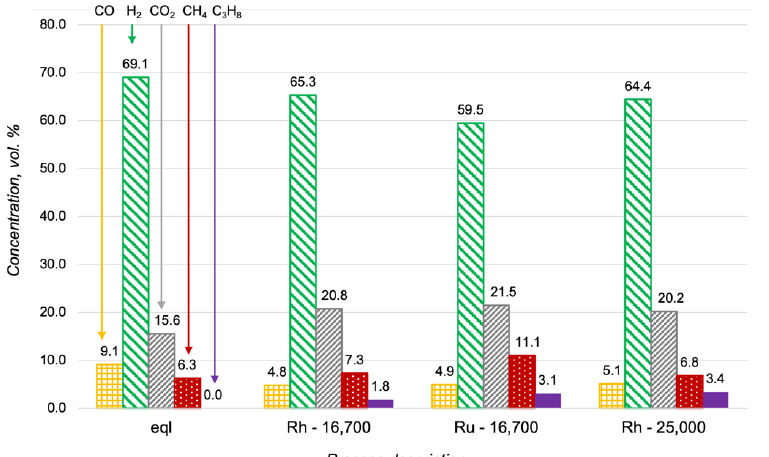
Figure 6. Product distribution in the propane steam reforming at 600 °C with H 2 O/C = 3 in a